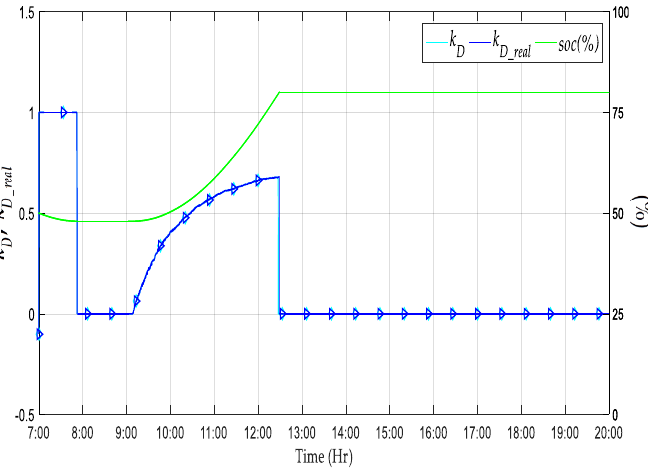
k , Figure 11. Evolution of Figure 11. Evolution of k D , k D _ real , and soc with optimization by applying the α D